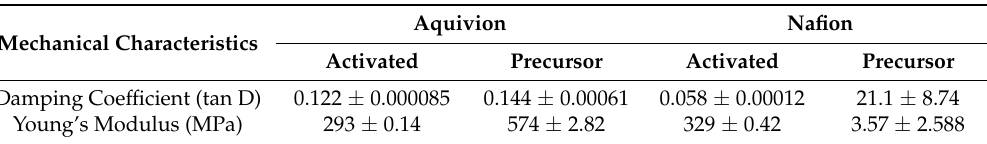
Figure 16. Young’s Modulus as the temperature increases for each precursor ionomer. Table 1. Comparison of the mechanical characteristics of activated and precursor forms of the ionomers at room temperature.